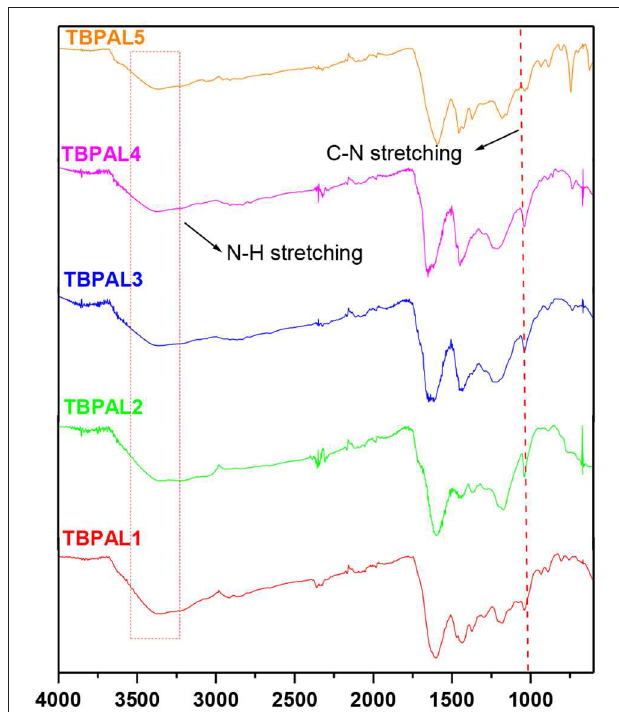
FIGURE 2 | FT-IR spectrum of TBPALs .